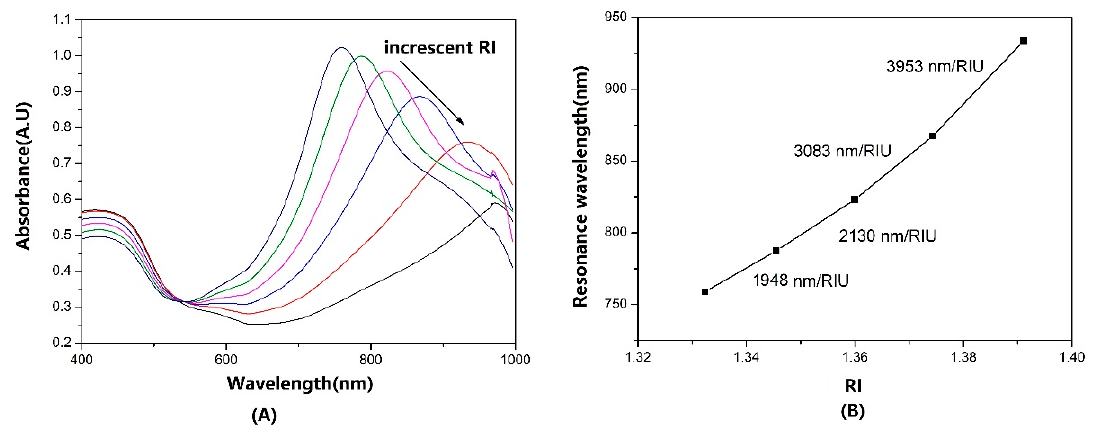
Figure 6. ( A ) The absorbance spectrums of 80 nm AuNS–modified fiber sensors in glycerol solutions, with RI range: 1.3322 to 1.4045. ( B ) The nonlinear increased S RI for RI range: 1.3322 to